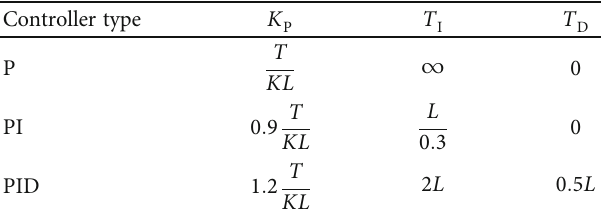
Table 2: Controller parameters for the Ziegler-Nichols method. Controller